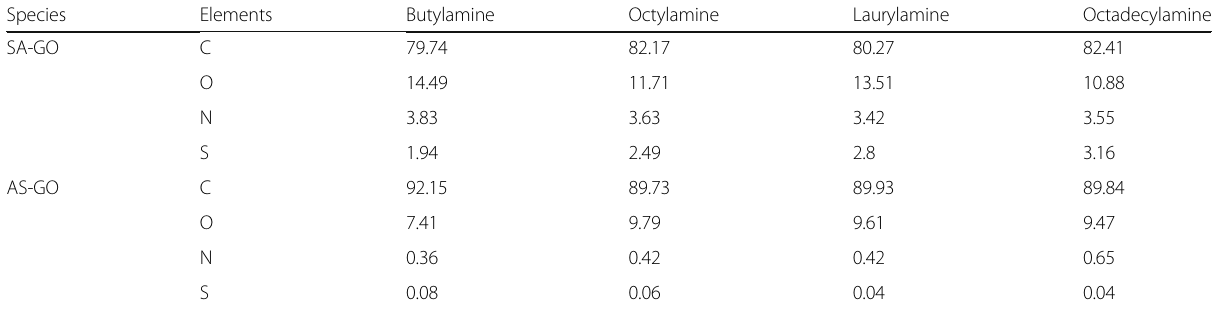
Table 1 The chemical composition of SA-GO and AS-GO determined by XPS (at%) Species